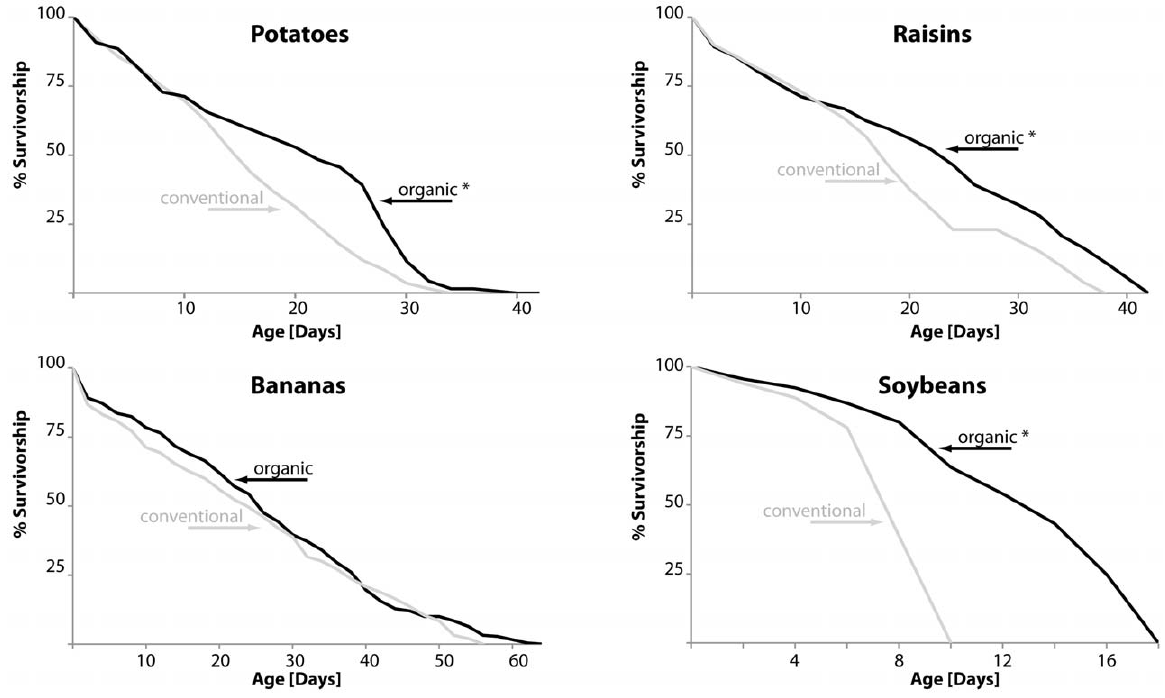
Figure 1. Longevity of D. melanogaster fed organic diets. Survivorship curves of female fruit flies fed diets made from extracts of potatoes, raisins, bananas or soybeans (grey: conventional food; black: organic food; statistically significant changes (p , 0.005) are indicated by asterisks). Median survival times of flies on conventional and organics food sources, respectively, are: potatoes: 16 and 22 days ( , 38% longevity increase, p , 0.0001); raisins: 2 and 24 days ( , 20% longevity increase, p , 0.0001); bananas: 24 and 26 days (p=0.1543); soybeans: 8 and 14 days ( , 75% longevity increase, p , 0.0001).